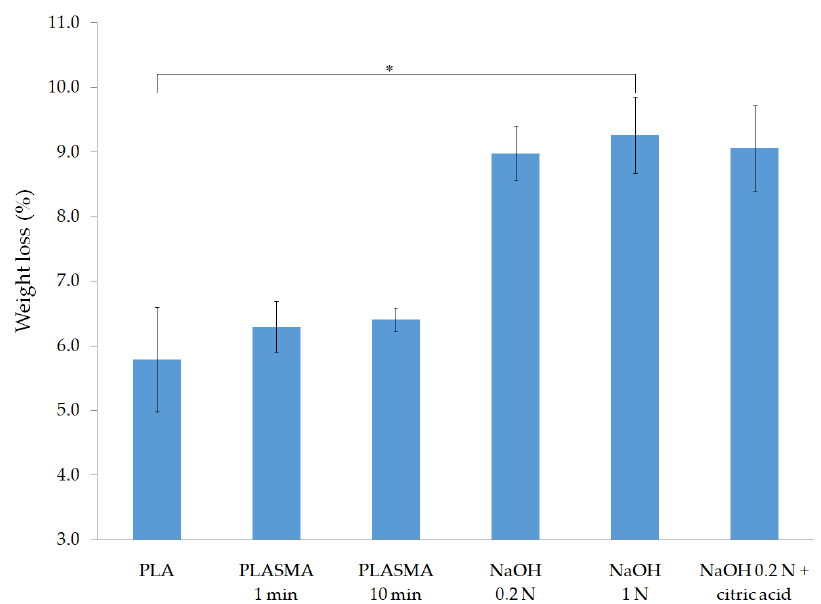
Figure 4. Enzymatic degradation test results of surface-treated samples: % weight loss after five days. * p < 0.05.